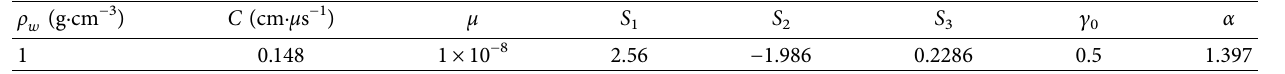
Table 2: Constitutive parameters for the water.